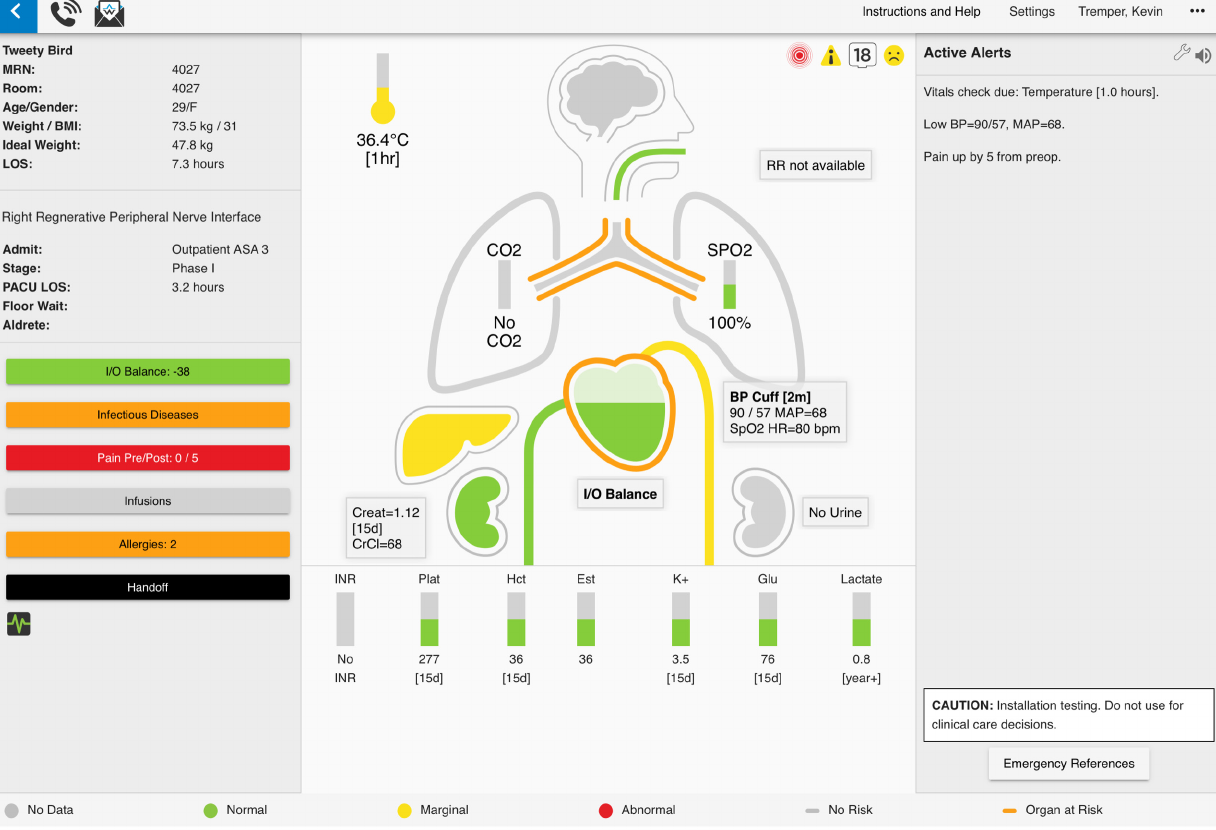
Figure 2. AlertWatch® decision-support software, customized for the post-anesthesia care unit (PACU)